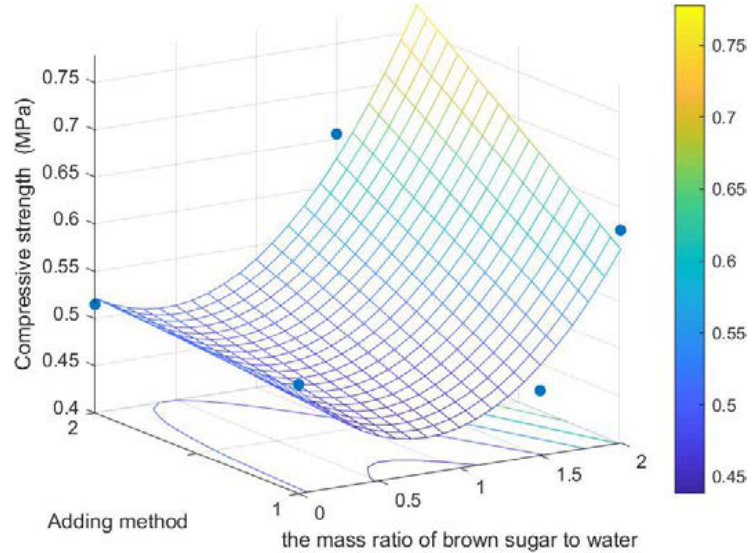
Figure 4. Relation diagram of compressive strength–the mass ratio of brown sugar to water and adding method.